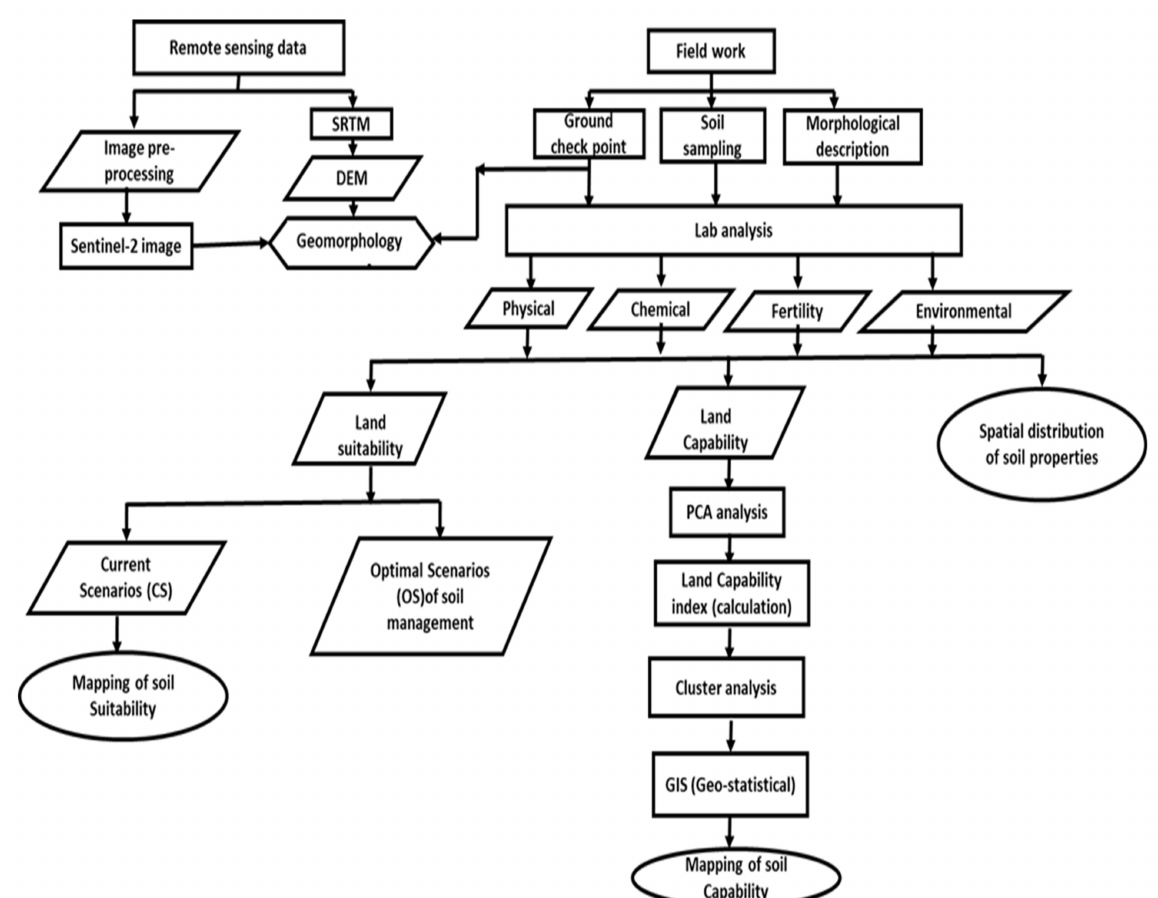
Figure 2. Flow chart illustrating methodology of current